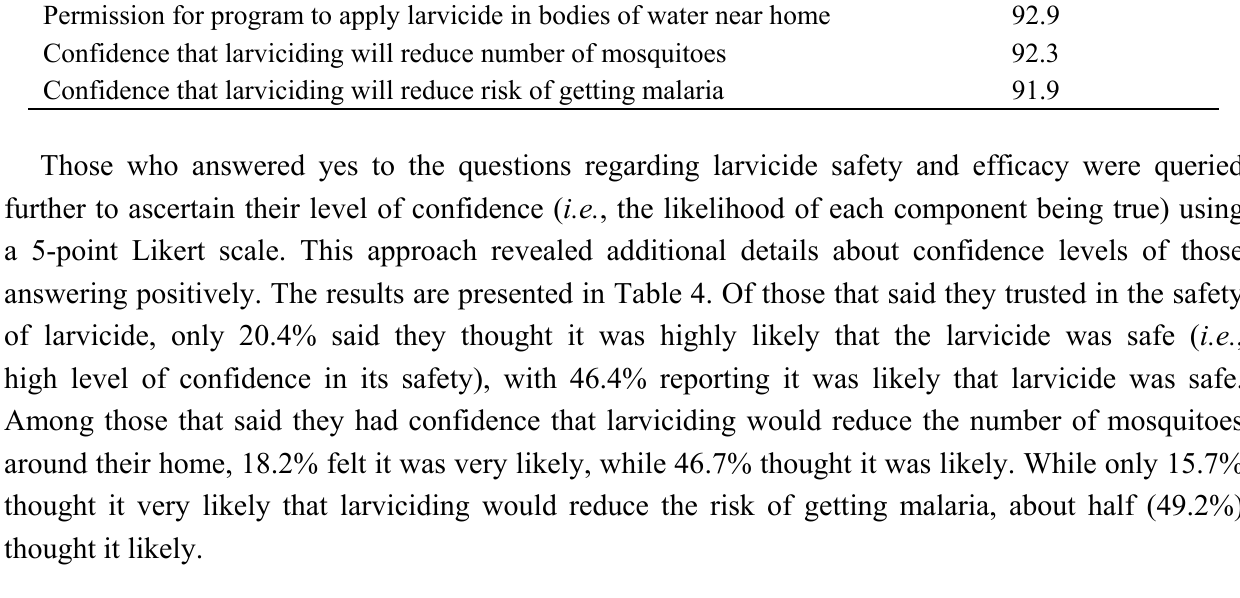
Table 4. Likert scale responses to questions regarding attitudes towards